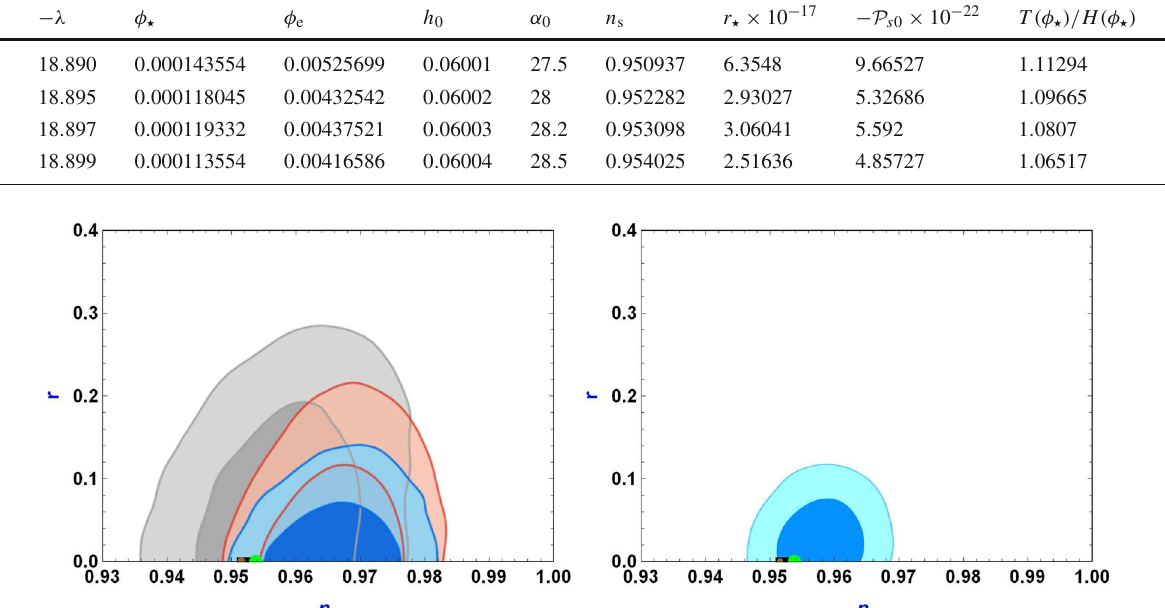
Fig. 7 The r – n s diagram comparing the predictions of the non- comoving warm inflation model in the strong dissipative regime with generalized de Sitter scale factors having the free parameters of Table 4, with the Planck 2013, 2015 and 2018 data sets. In the left panel, the likelihood of Planck 2013 are indicated with gray contours, Planck TT+lowP with red contours, and Planck TT,TE,EE+lowP (2015) with